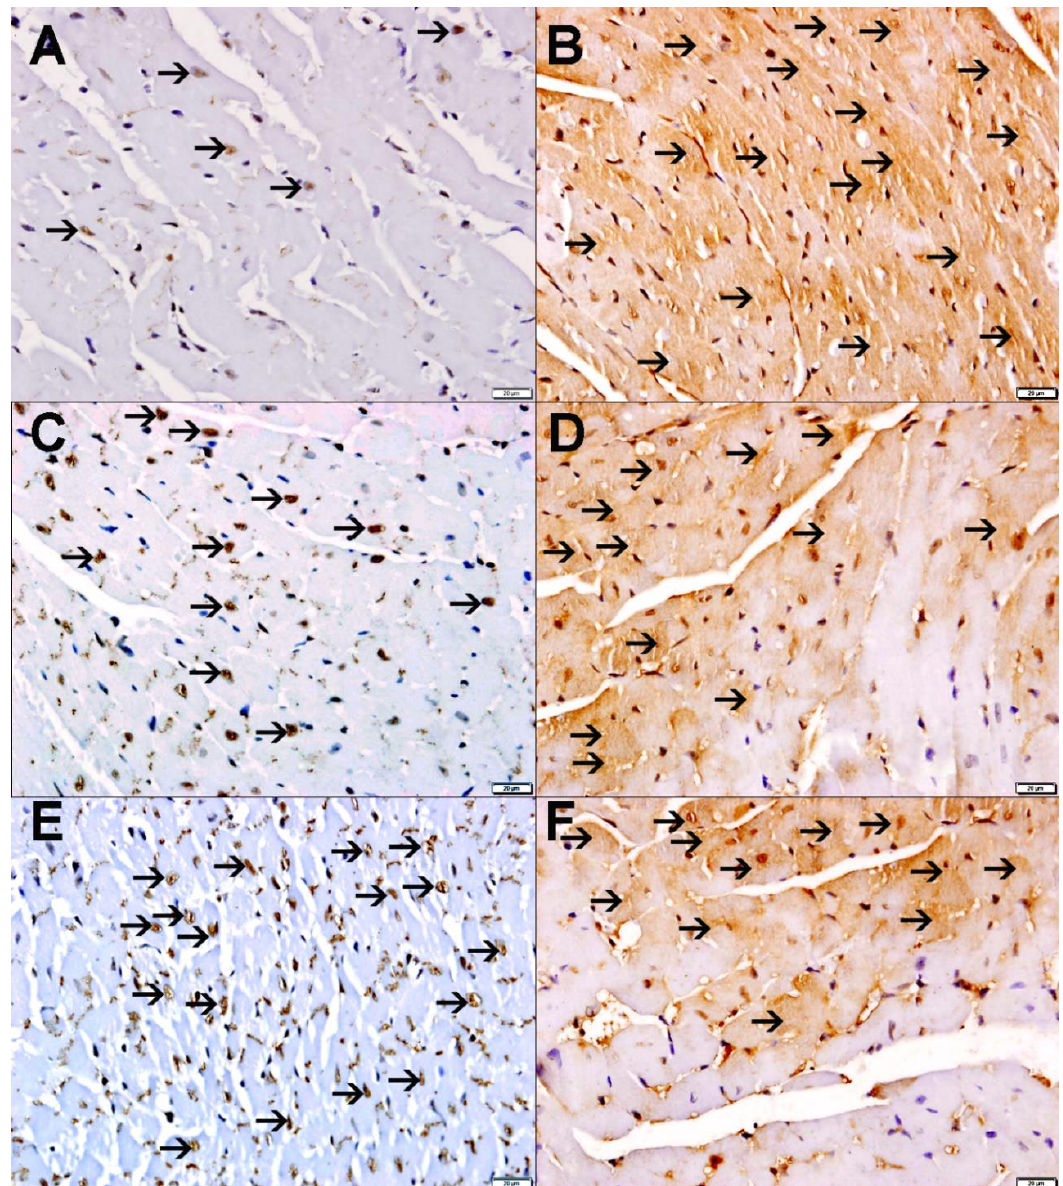
Figure 10. Effects of plain water-pipe smoke (P-WPS) or apple-flavoured (AF)-WPS on the immunohistochemistry detection of nuclear factor erythroid-derived 2-like 2 (Nrf2) or superoxide dismutase (SOD) in the heart. Immunohistochemical analysis of the heart tissue sections of mice for the detection of Nrf2 ( A , C , E ) and SOD ( B , D , F ) at the end of 1 mo exposure period to either air or P-WPS or AF-WPS. ( A ) Representative section of the heart of air-exposed mice showing focal mild nuclear expression of Nrf2 by cardiac myocytes (arrow). ( B ) Representative section of the heart of air-exposed mice showing diffuse cytoplasmic expression of SOD by cardiac myocytes (arrow). ( C ) Representative section of the heart of P-WPS-exposed mice showing nuclear expression of Nrf2 by cardiac myocytes (arrow). ( D ) Representative section of the heart of mice exposed to P-WPS showing cytoplasmic expression of SOD by cardiac myocytes (arrow). ( E ) Representative section of the heart of AF-WPS-exposed mice showing nuclear expression of Nrf2 by cardiac myocytes (arrow). ( F ) Representative section of the heart of mice exposed to AF-WPS showing cytoplasmic expression of SOD by cardiac myocytes (arrow). The scale bar equals 50 μm.